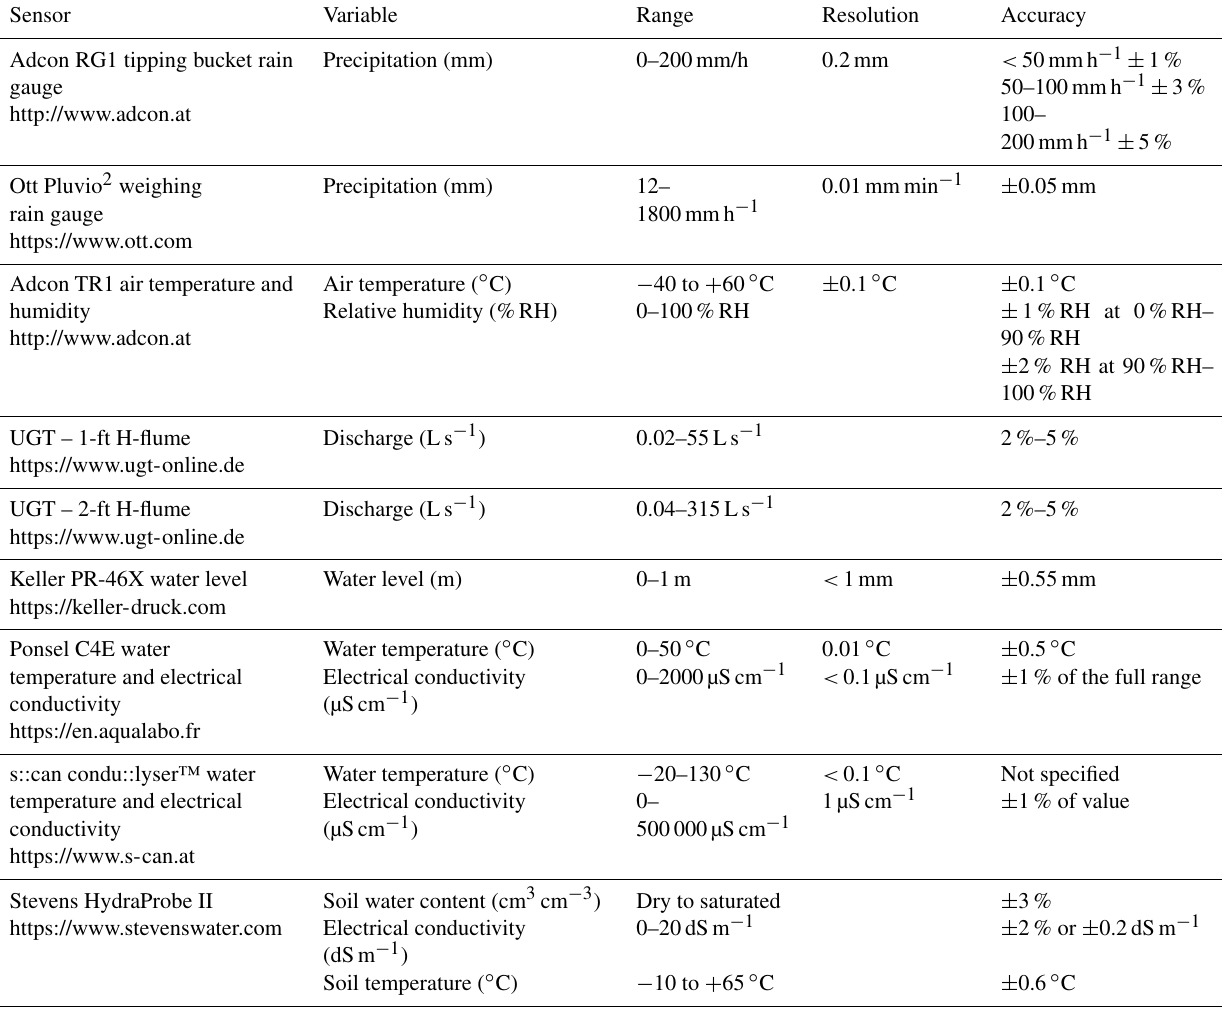
Table 2. Specifications of sensors. Last access date of all URLs: 29 June